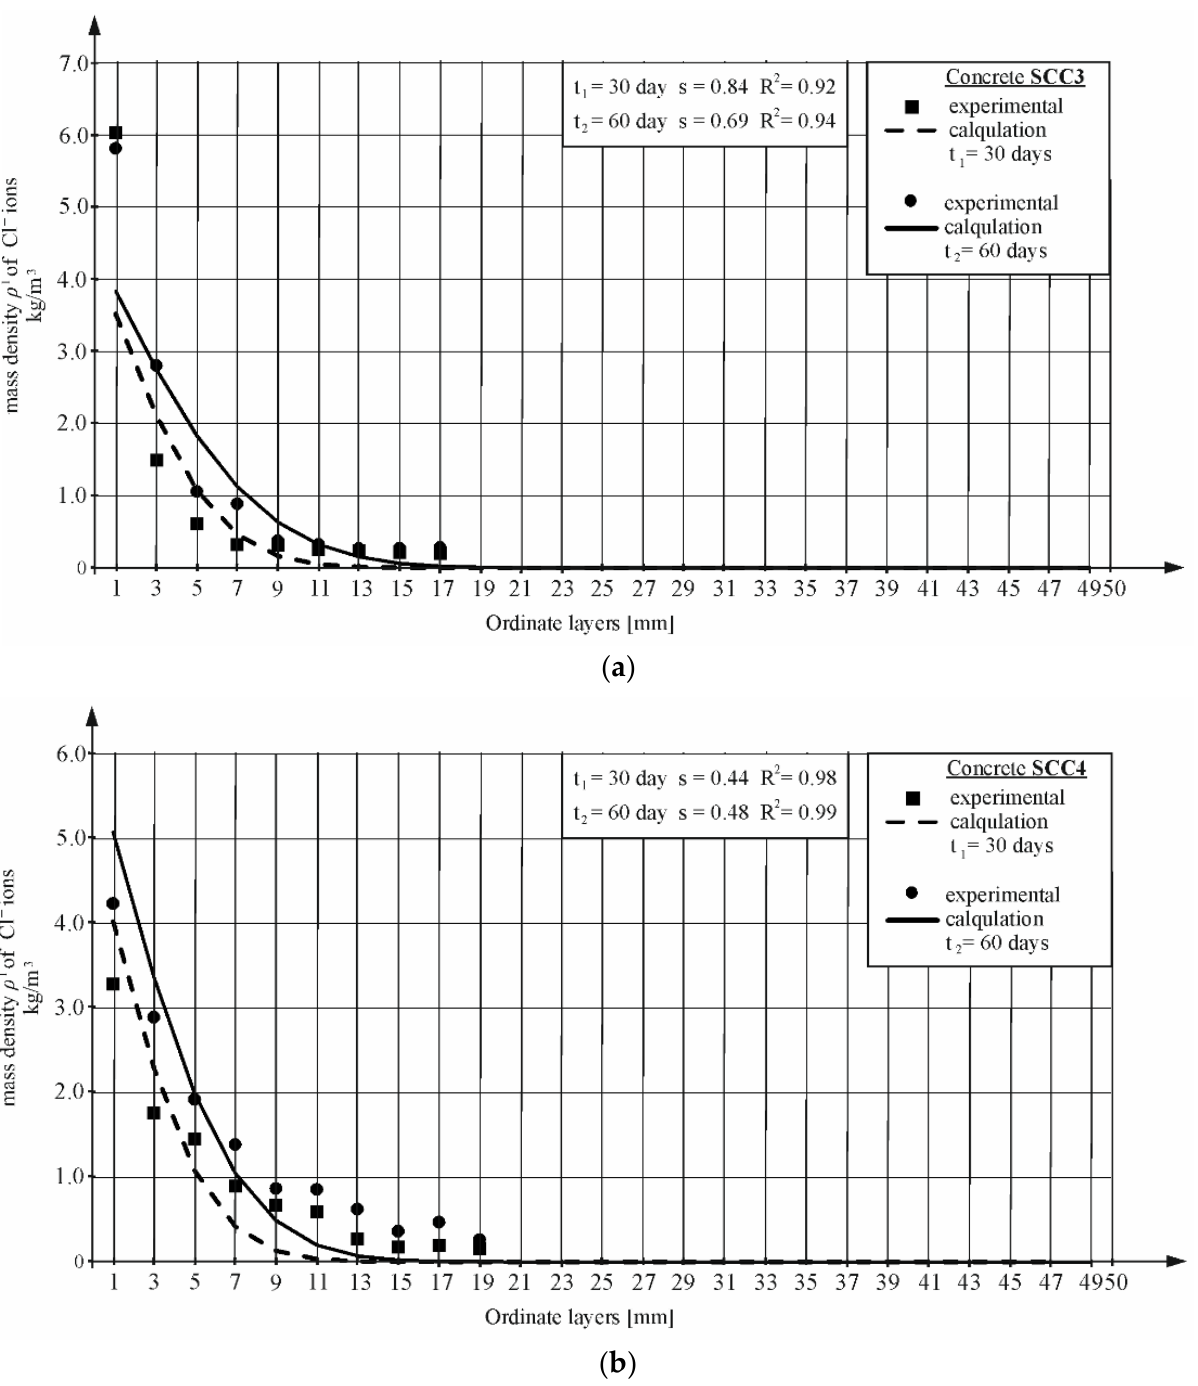
Figure 7. Chloride ion profile determined in diffusion tests in time t 1 and t 2 and calculated using the Equations (4) and (5) in concrete (TD1 and TD2): ( a ) SCC3; ( b ) SCC4.